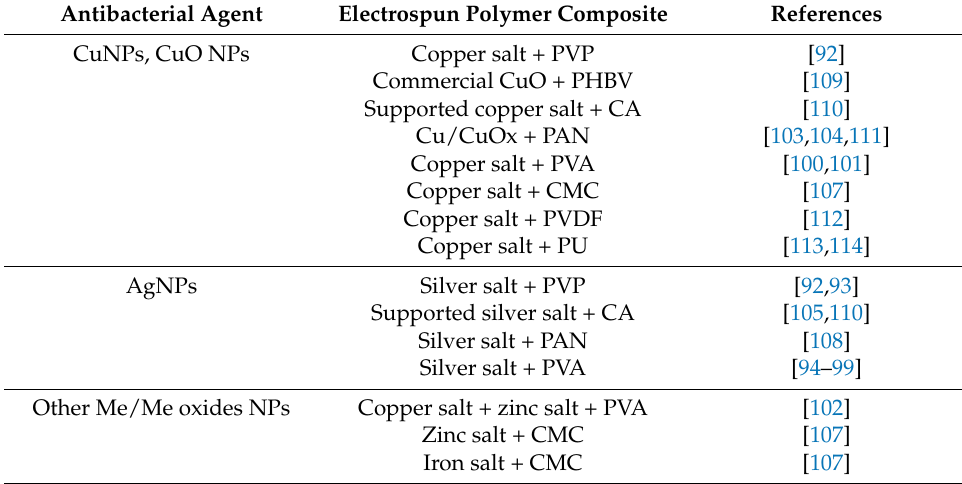
Some representative studies where electrospun antibacterial nanofibers incorporate metal